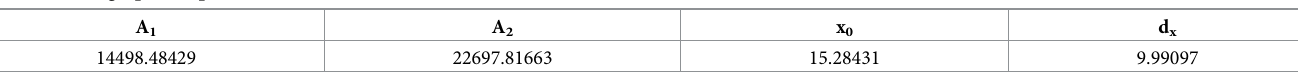
Table 26. Fitting equation parameters of cost of 30–23.